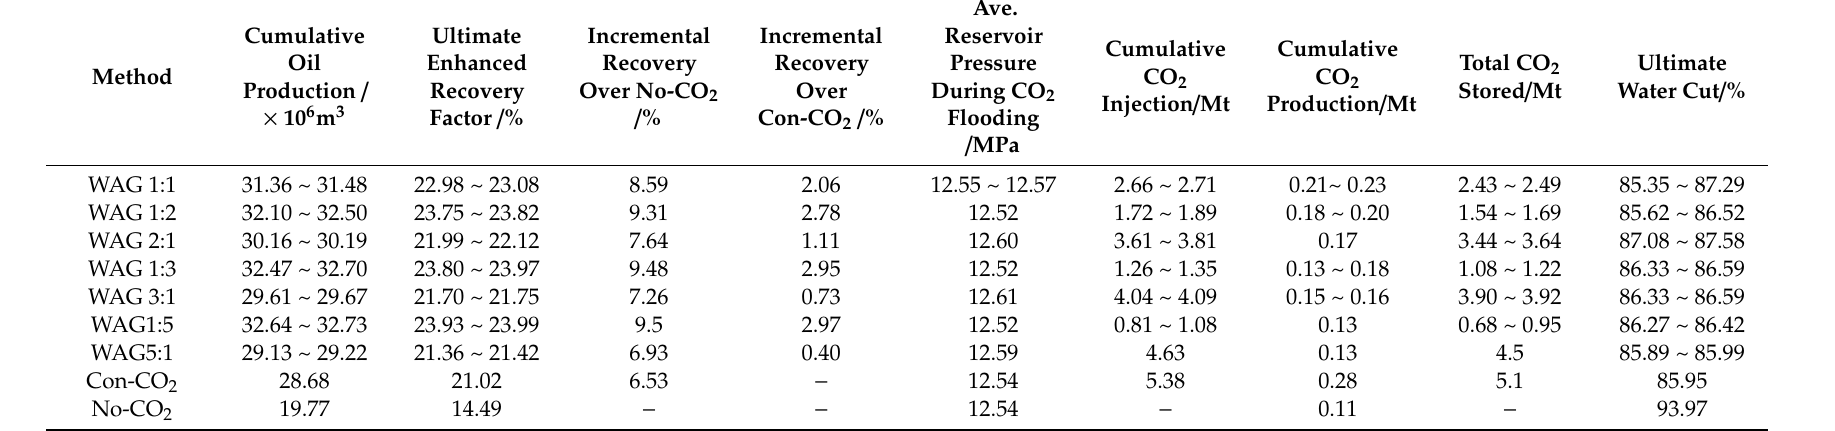
Table 6. Simulation results of di ff erent simulation scenario